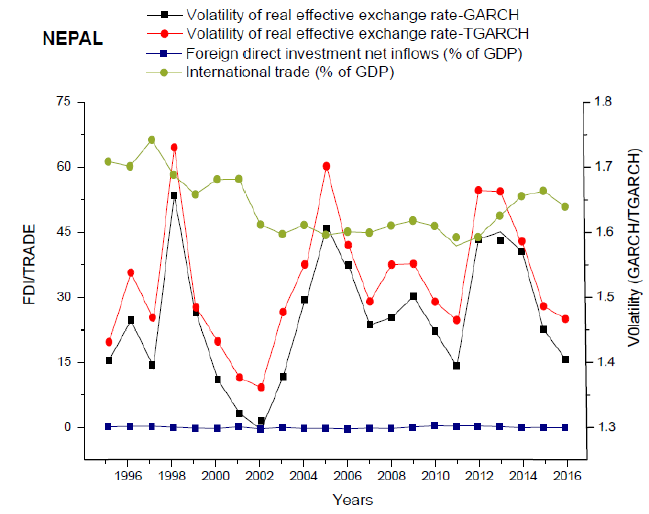
Figure 5. Exchange Rate Volatility vs. FDI/Trade (Nepal).